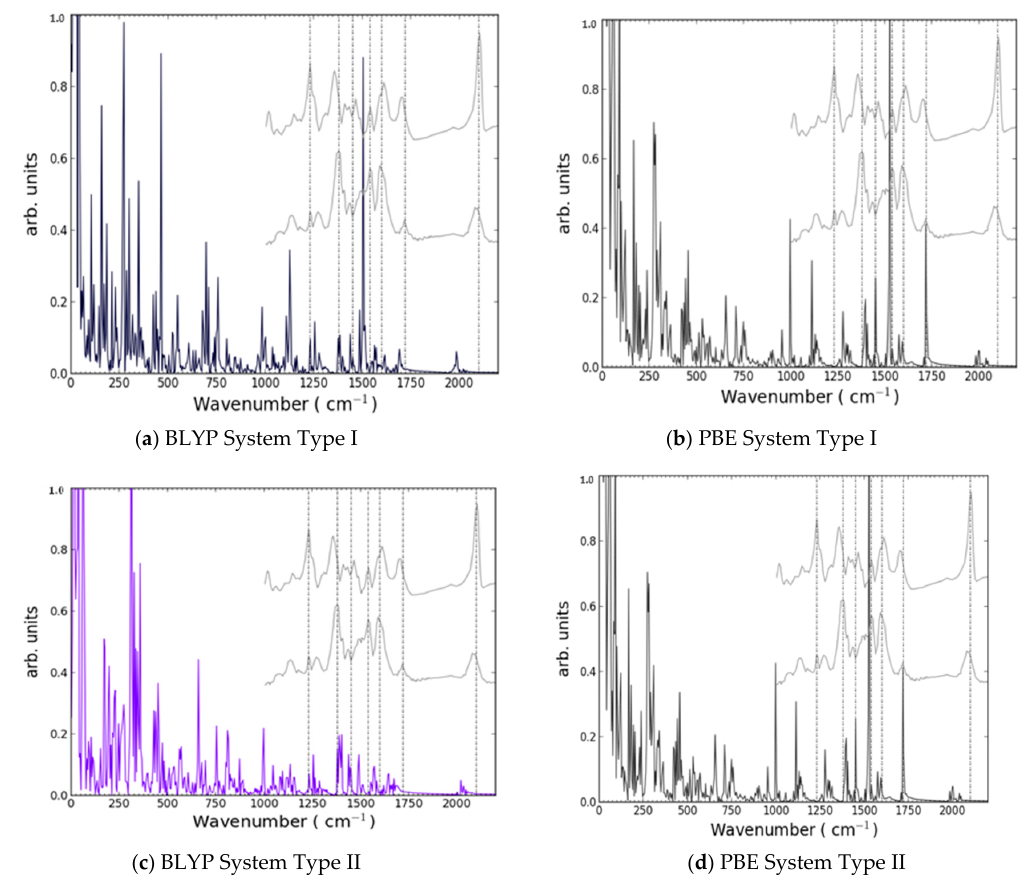
Figure 2. Vibrational Spectra of ( a ) BLYP system I, ( b ) PBE system I, ( c ) BLYP system II and ( d ) PBE system II. Within each plot the grey (lower)/(upper) inset corresponds to the experimental ATR-FTIR signal from reference [25] for (dry-N719 adsorbed onto anatase)/(dry-N719 powder). The dashed lines indicate established vibrational modes [26].